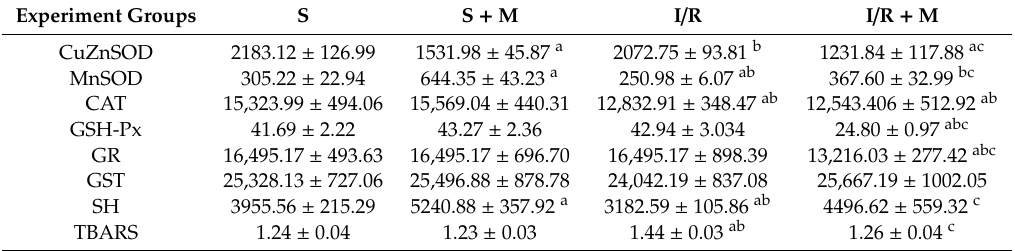
Table 2. Activities of kidney copper-zinc superoxide dismutase (CuZnSOD, U / g wet mass), manganese superoxide dismutase (MnSOD, U / g wet mass), catalase (CAT, µ mol H 2 O 2 / min / g wet mass), glutathione peroxidase (GSH-Px, µ mol NADPH / min / g wet mass), glutathione reductase (GR, nmol NADPH / min / g wet mass), and glutathione S-transferase (GST, nmol GSH / min / g wet mass), as well as kidney concentrations of sulfhydryl groups (SH, nmol / g tissue) and lipid peroxides (TBARS, nmol / g